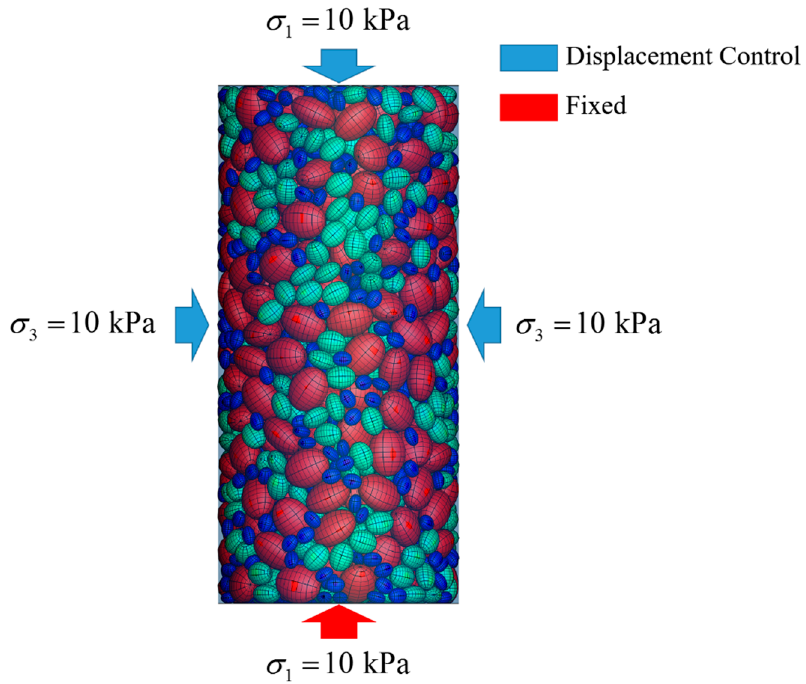
Figure 5. Boundary condition and loading of the triaxial Figure 6. Boundary condition and loading of the triaxial test.